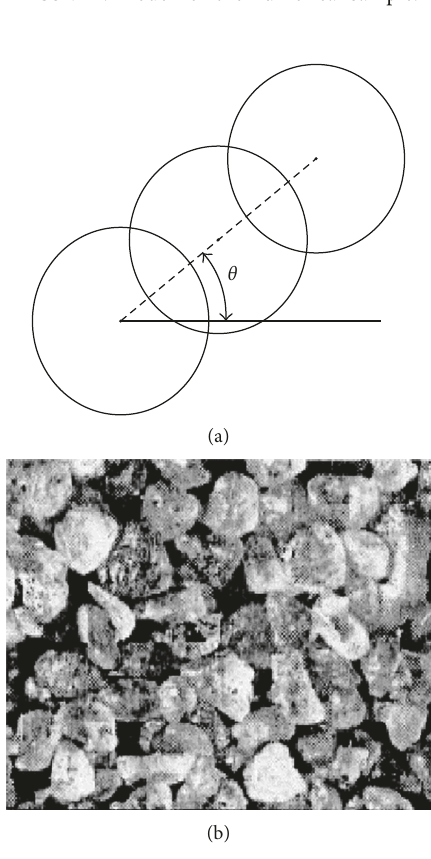
Figure 2: Comparison between irregular element and Fujian sand.